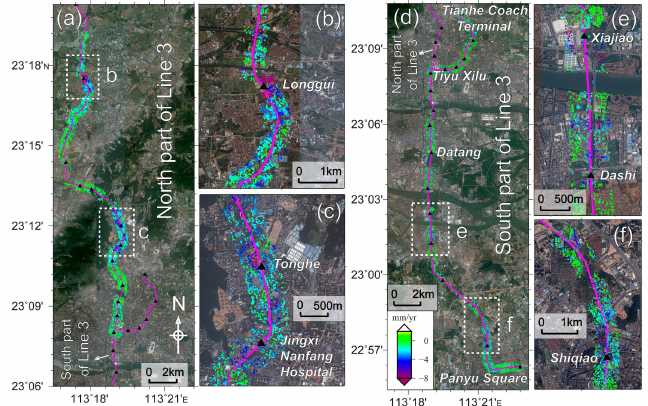
Figure 5. ( a ) and ( d ) PALSAR deformation rate maps of Line Three. Regions b, c, e, and f, marked with white dashed rectangles, are four subsiding areas along Line 3, and their enlarged figures are shown in ( b ), ( c ), ( e ), and ( f ),